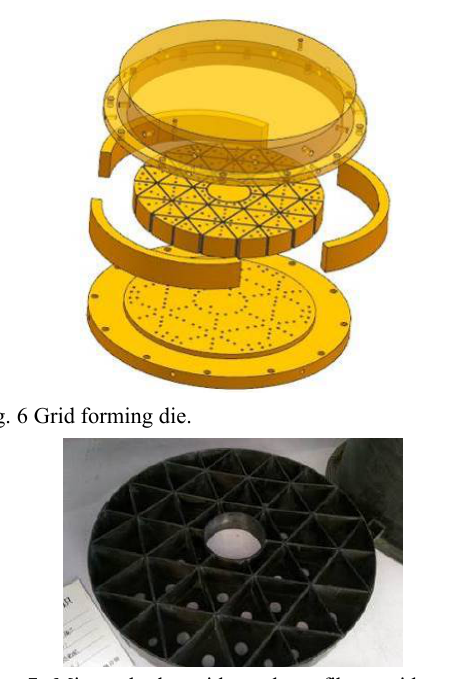
Fig. 7 Mirror body with carbon fiber grid reinforced structure.